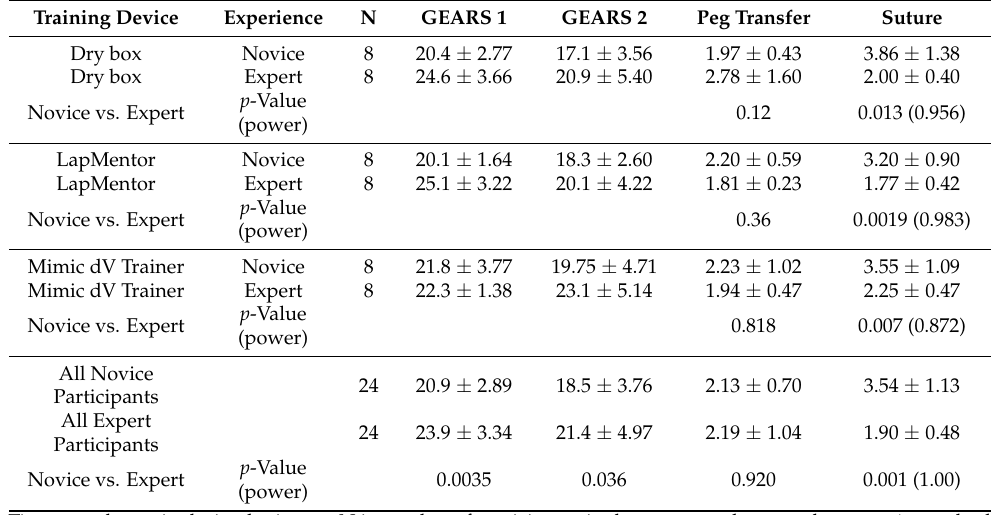
Table 4. Peg transfer and suture exercises performed on the da Vinci robot system (day